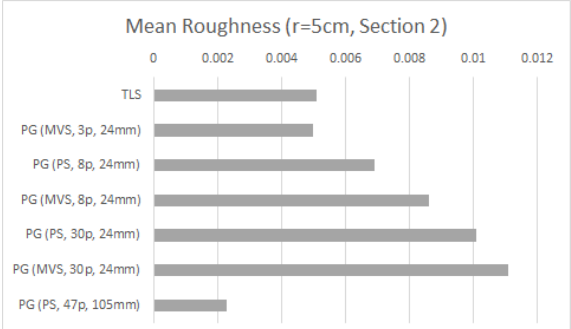
Figure 9. Mean point-cloud roughness within a sphere of 5 cm of radius for a zone of the rockfall for different acquisition and processing configurations. TLS: Terrestrial Laser Scanning, PG: Photogrammetry, PS: Agisoft Metashape, MVS: OpenMVS.